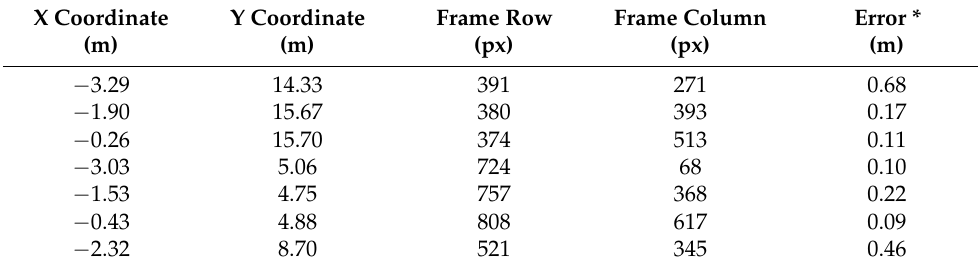
Table A3. GCP of Loussios river case study at Atsicholos Bridge.